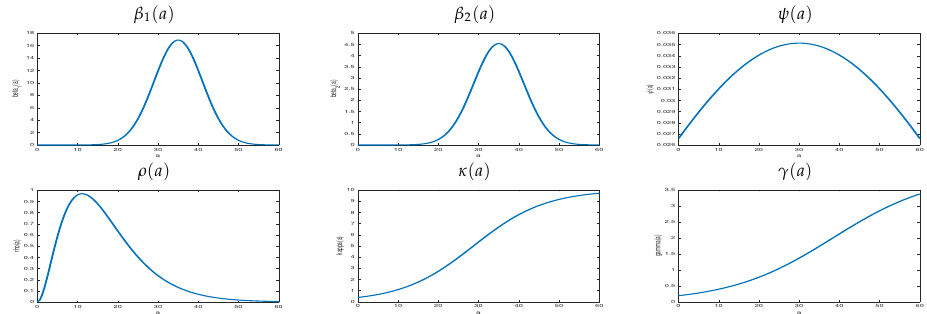
Figure 1. The images of age-dependent parameters of model